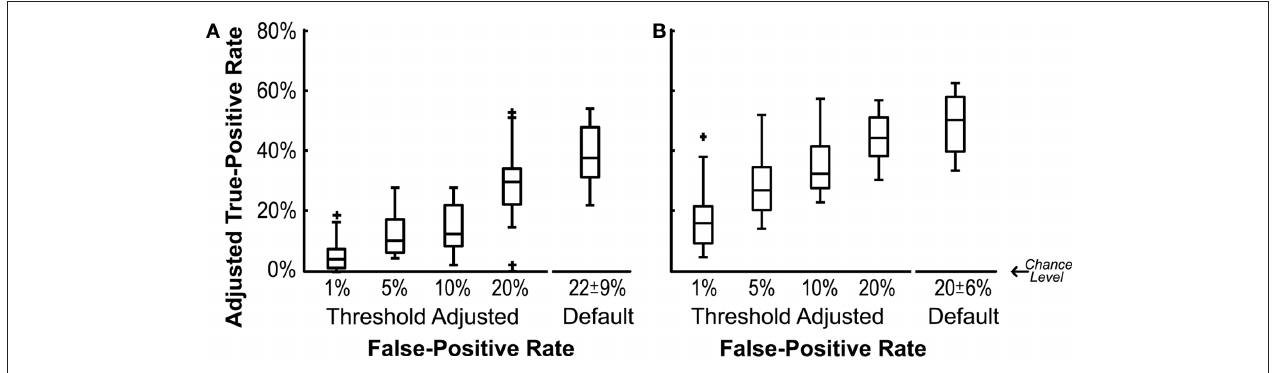
Figure 2 | Adjusted true-positive rate as a function of false-positive rate. Adjusted true-positive rate was calculated as the true-positive rates during the motor-planning epoch minus the false-positive rate during the relaxed epoch. Boxes indicate 25, 50, and 75% quartiles respectively.